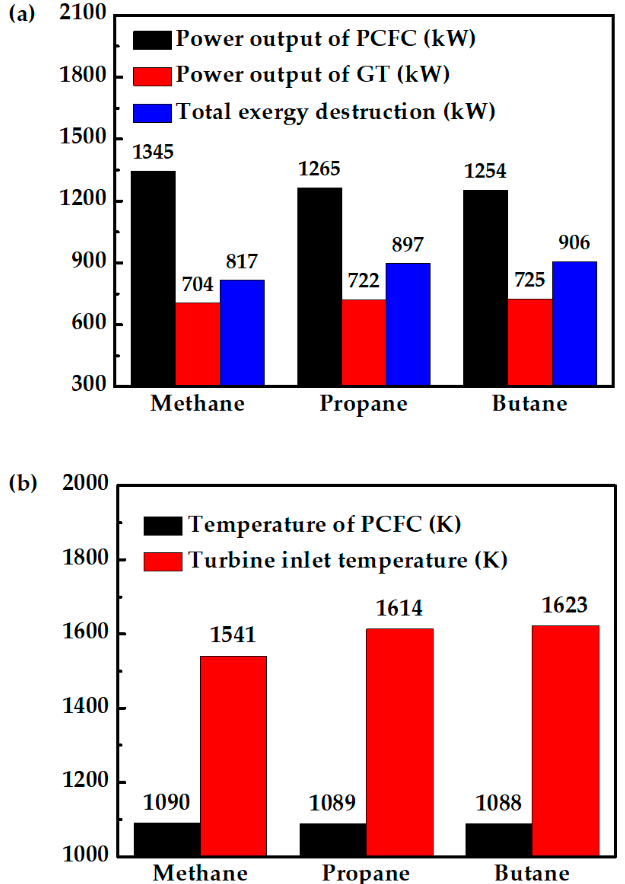
Figure 10. Comparison of methane‑, propane‑, and butane‑fueled PCFC/GT hybrid systems: ( a ) PCFC power output, GT power output and total exergy destruction of system, and ( b ) PCFC operating temperature and turbine inlet temperature.